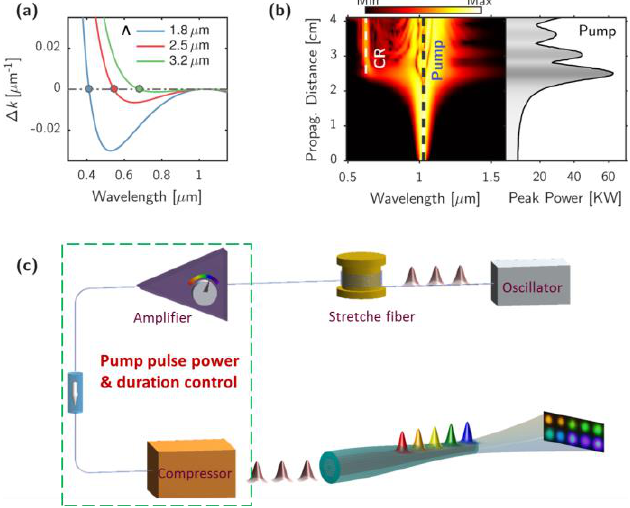
Fig. 1. Principle and experimental setup of tunable femtosecond fiber laser. (a) Phase- matching curves of FOCR generation with different fiber dimensions.  is the PCF pitch. (b) With a transform-limited Gaussian input pump pulse at 1035 nm, the simulated spectrum evolution (left) and peak power evolution (right) of the pulse along a tapered PCF for FOCR generation at 580 nm. (c) General layout of the tunable FOCR